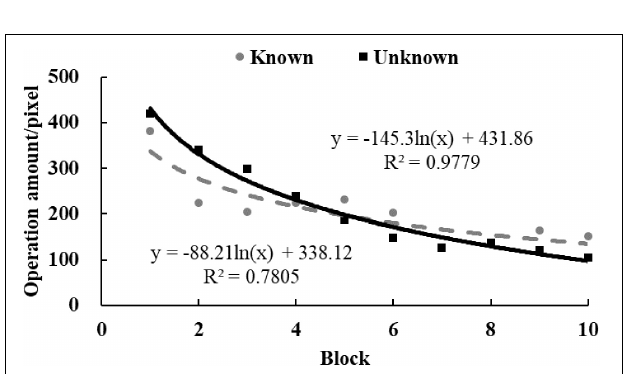
FIGURE 8 | The M of decision time in Study 3. The solid and dotted lines represent the regression curves for the unknown and known conditions, respectively.